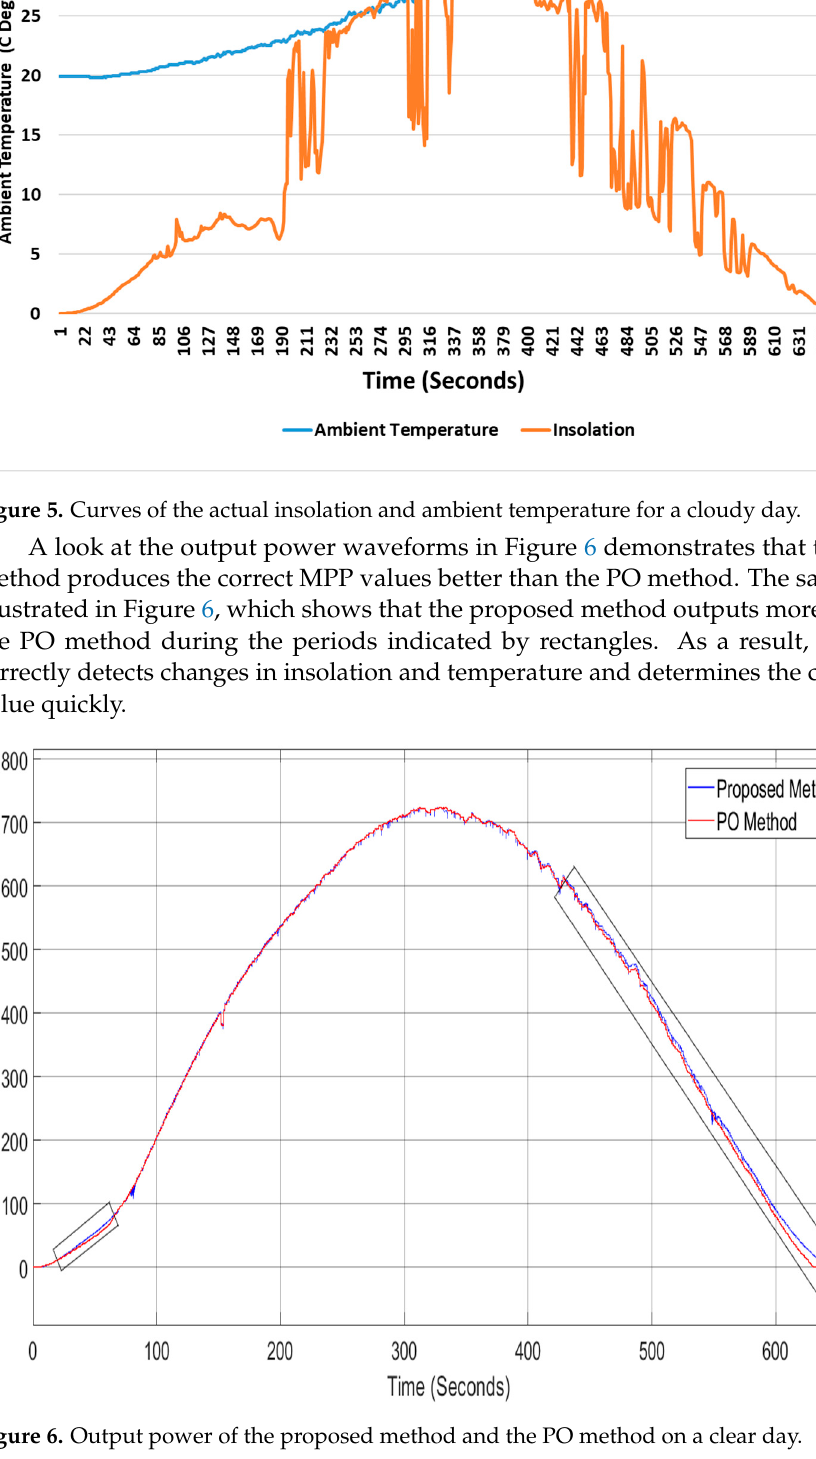
Figure 4. Curves of the actual insolation and ambient temperature for a clear day.